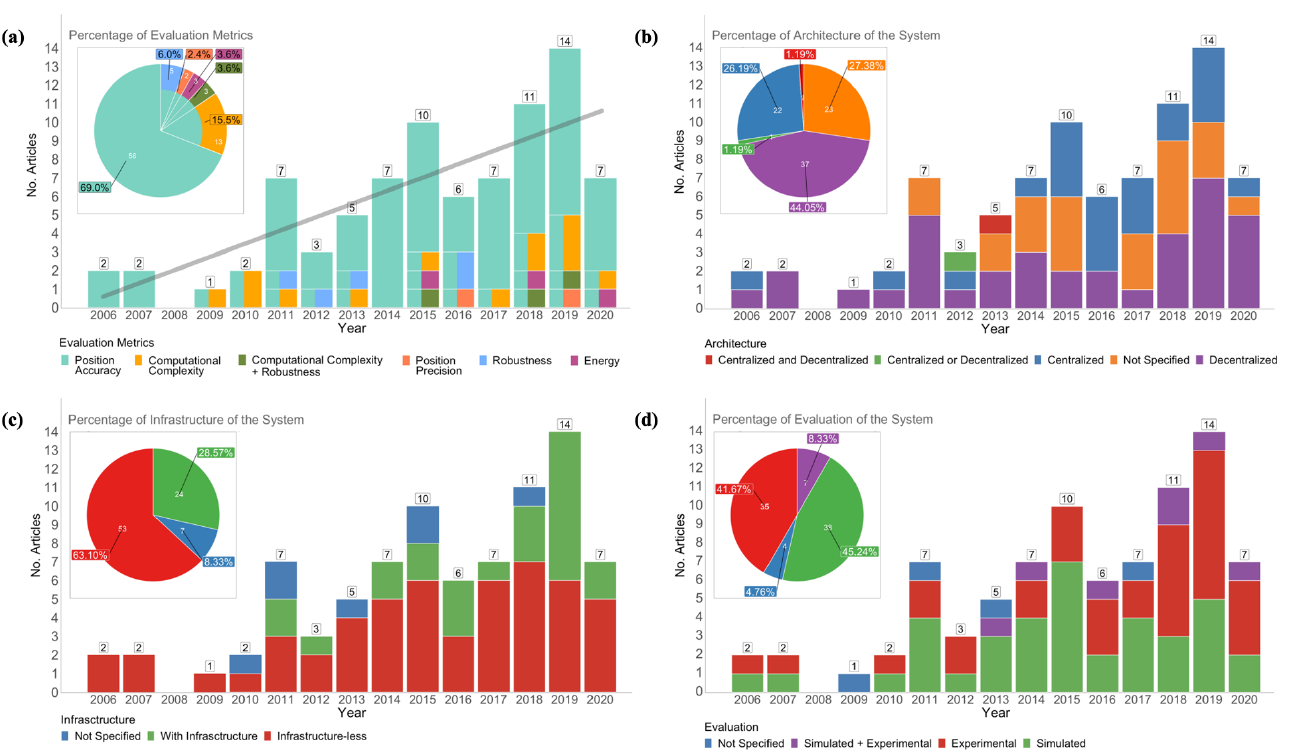
Figure 4. Evolution of the systems over time. ( a ) Distribution of the studies with their evaluation metrics. ( b ) Evolution of the systems’ architecture. ( c ) Evolution of the systems’ infrastructure. ( d ) Evolution of the systems’ evaluation. Source: